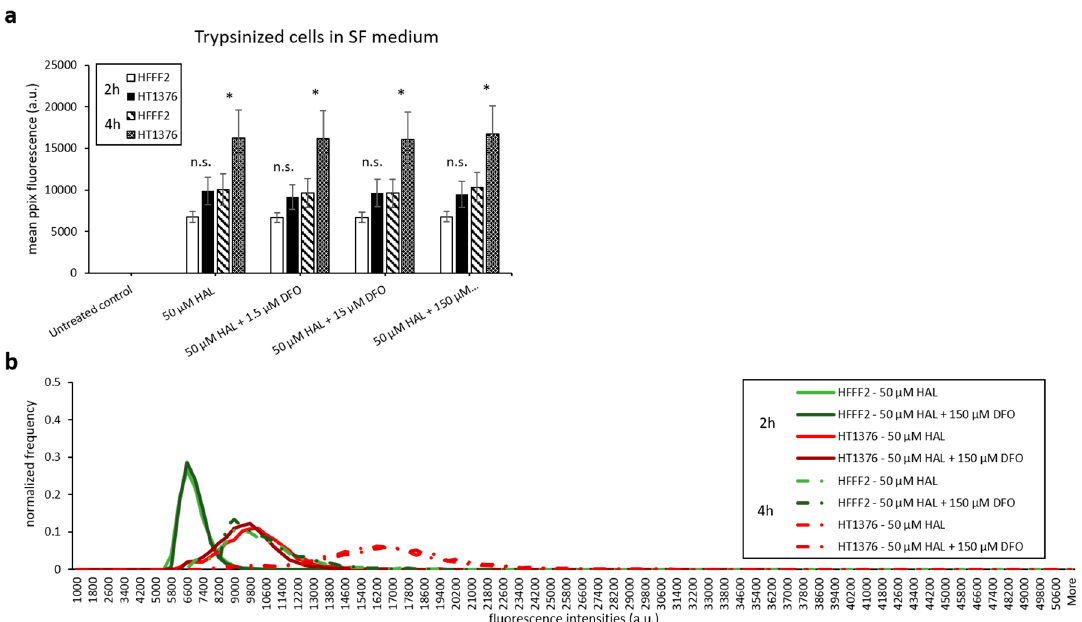
Figure 7. Effect of DFO and HAL treatment on PpIX fluorescence in human bladder cancer HT1376 and human fibroblast HFFF2 cells. Trypsinised cells were incubated with HAL (50 µM) alone or HAL (50 µM) and different concentrations of DFO (1.5 to 150 µM) in their respective serum-free (SF) medium for 2 and 4 h. Mean ± SD ( n = 3), statistical significance by ANOVA. n.s. = not significant and * p < 0.05, compared between bladder cancer HT1376 and fibroblast HFFF2 in the same conditions. PpIX fluorescence was measured, and results are expressed in ( a ) bar and ( b ) histogram graphs.